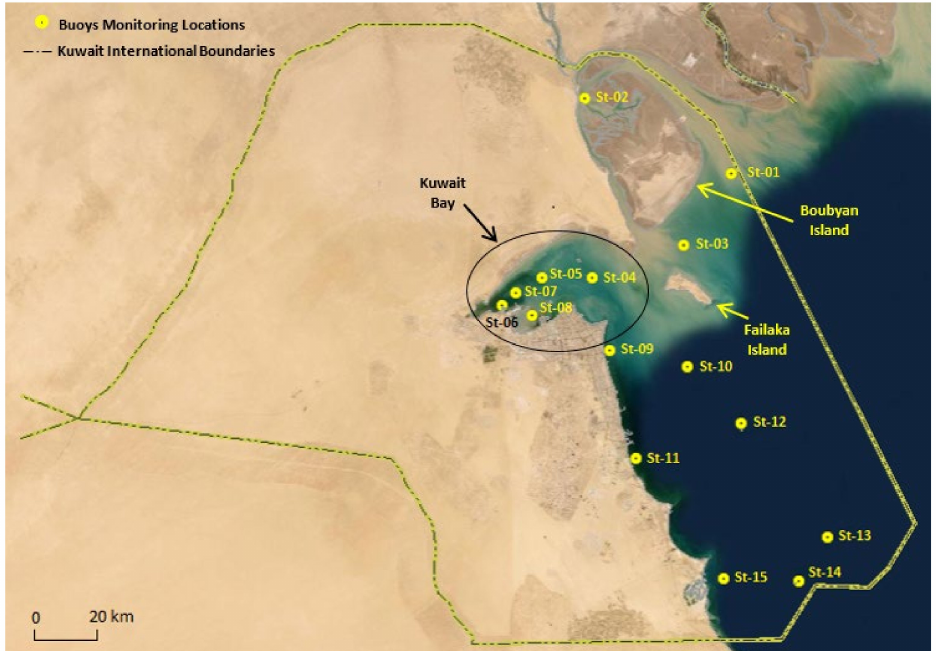
Figure 1. KEPA Monitoring Buoys